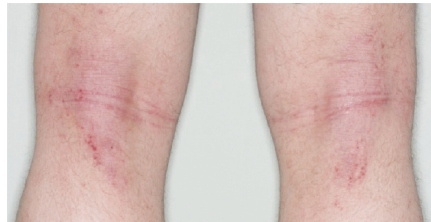
Figure2:Ill-definederythematouspatchesonthebacksoftheknees with scaling, lichenification, and